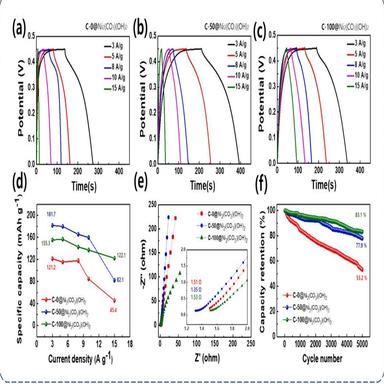
Galvanostatic CD curves of (a) C-0@Ni2(CO3)(OH)2, (b) C-50@Ni2(CO3)(OH)2, and (c) C-100@Ni2(CO3)(OH)2 compounds; (d) specific capacities of electrodes; (e) EIS Nyquist plot (inset shows the magnified EIS Nyquist plot); (f) cycling stability of the electrodes.